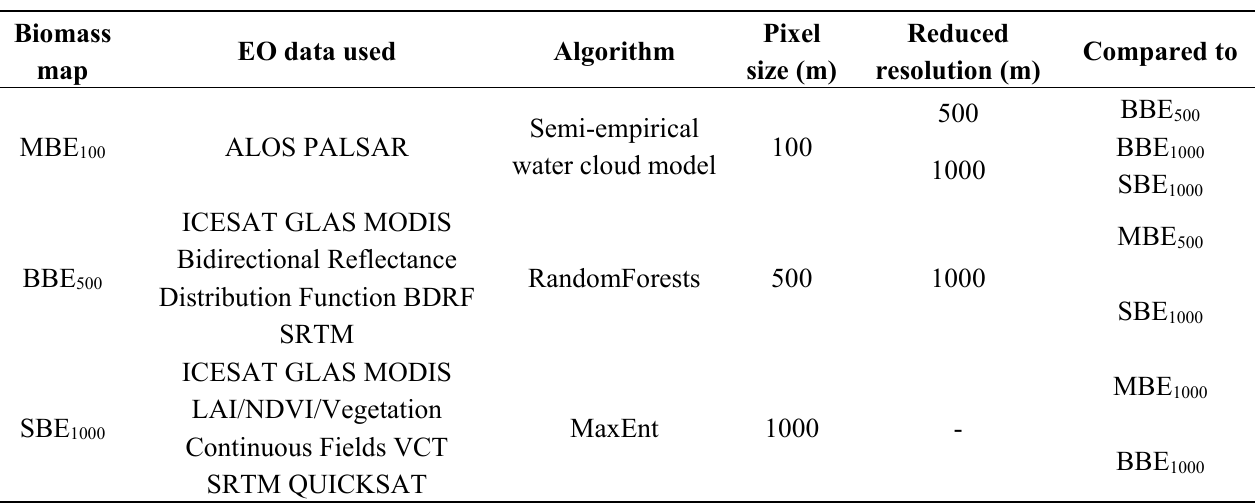
Table 3. Local and pantropical datasets used for comparison and summary of the data and methods used to derive the biomass maps; MBE, Michelakis biomass estimates; BBE, Baccini biomass estimates; SBE, Saatchi biomass